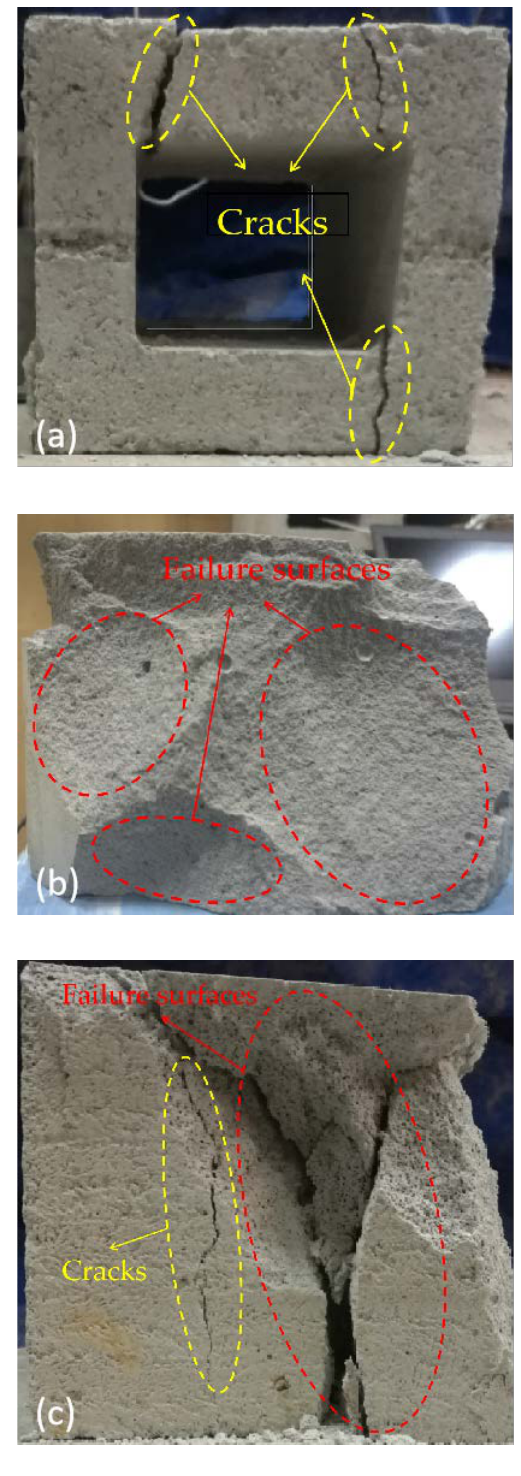
Figure 2. Samples after drop-weight test: ( a ) CHB; ( b ) AAC; ( c ) FC. In contrast to CHB, AAC and FC collapsed with a loss of integrity due to the occur- rence of failure surfaces throughout the sample as shown in Figure 2b,c, respectively.